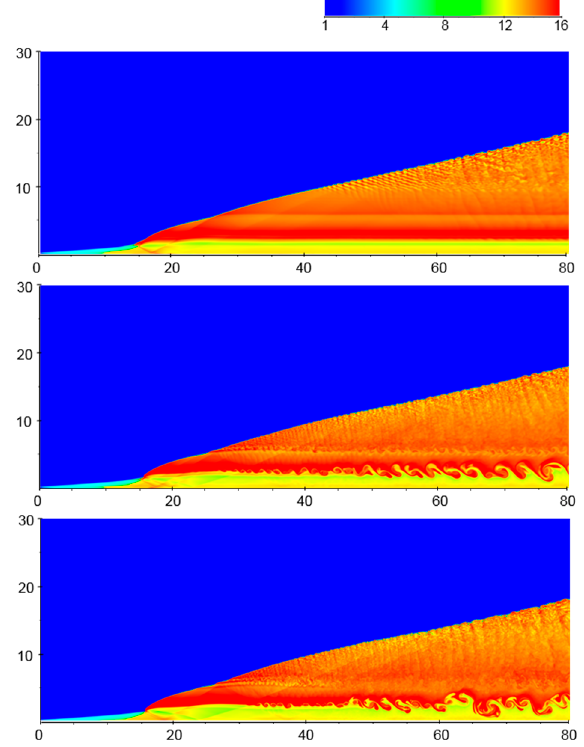
Figure 2. Temperature contours with 32 (upper), 64 (middle) and 128 (lower) pts/ l 1/2 for M 0 = 12.5, θ = 26° and E a = 60 for the one-step Arrhenius kinetics with k = 14,640.